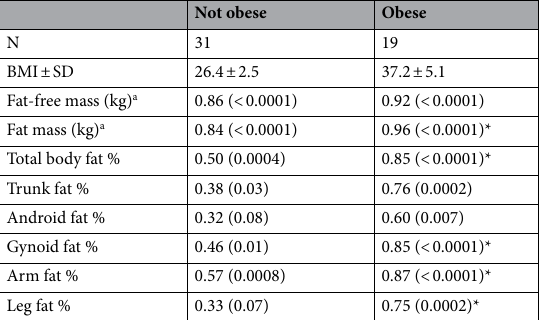
Table 4. Spearman correlations between dual X-ray absorptiometry (DXA) and bioimpedance (BIA)-assessed body composition by obesity status. Data are shown as Spearman’s rho (p-value) unless otherwise noted. “Obese” was defined as a BMI ≥ 30. *Denotes correlation is significantly different from “Not Obese” group (p < 0.05). a n non-obese = 29, n obese =